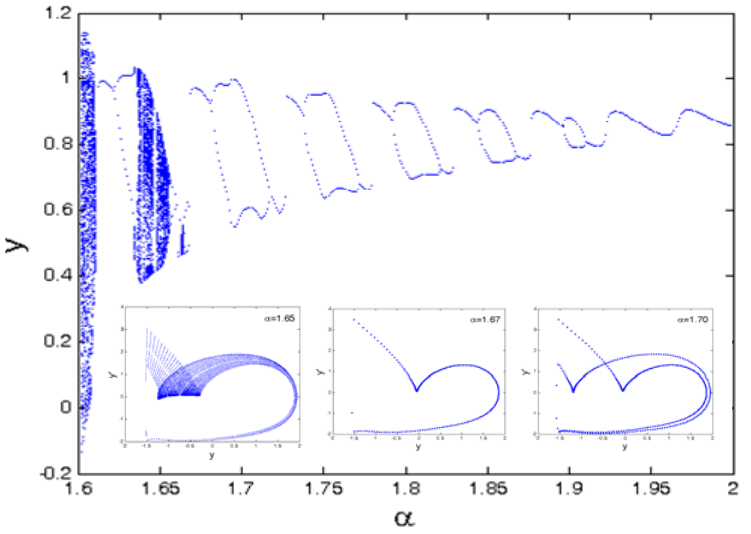
Figure 16. Local bifurcation and Poincaré maps of equilibrium parameter 